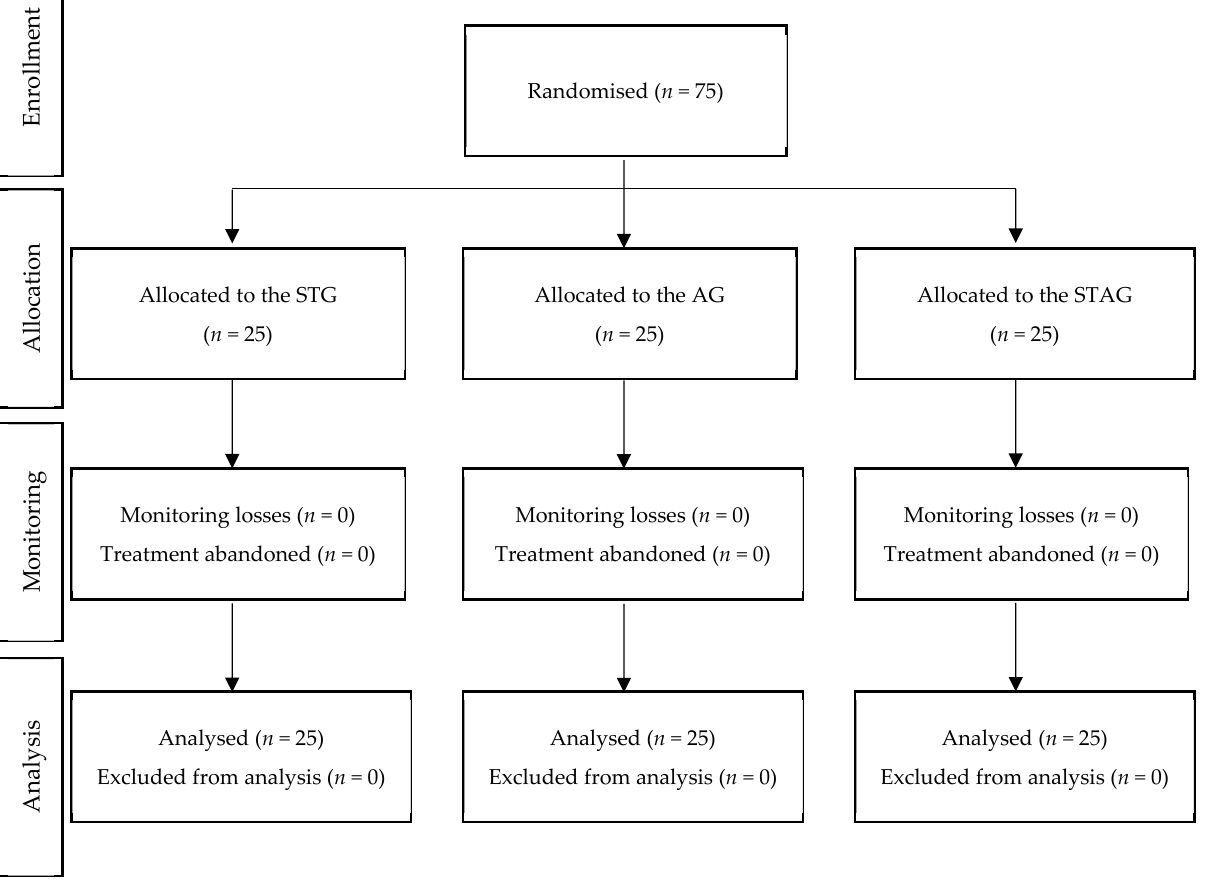
Figure 1. Flowchart according to CONSORT Statement for the Reporting of Randomised Trials. STG: Soft tissue group; AG: articulatory group; STAG: soft tissue and articulatory group. Table 1. Descriptive analysis of the sample at